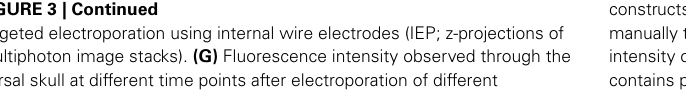
constructs (EEP in dorsal telencephalon). Fluorescence intensity was scored manually through a fluorescence stereomicroscope and normalized to